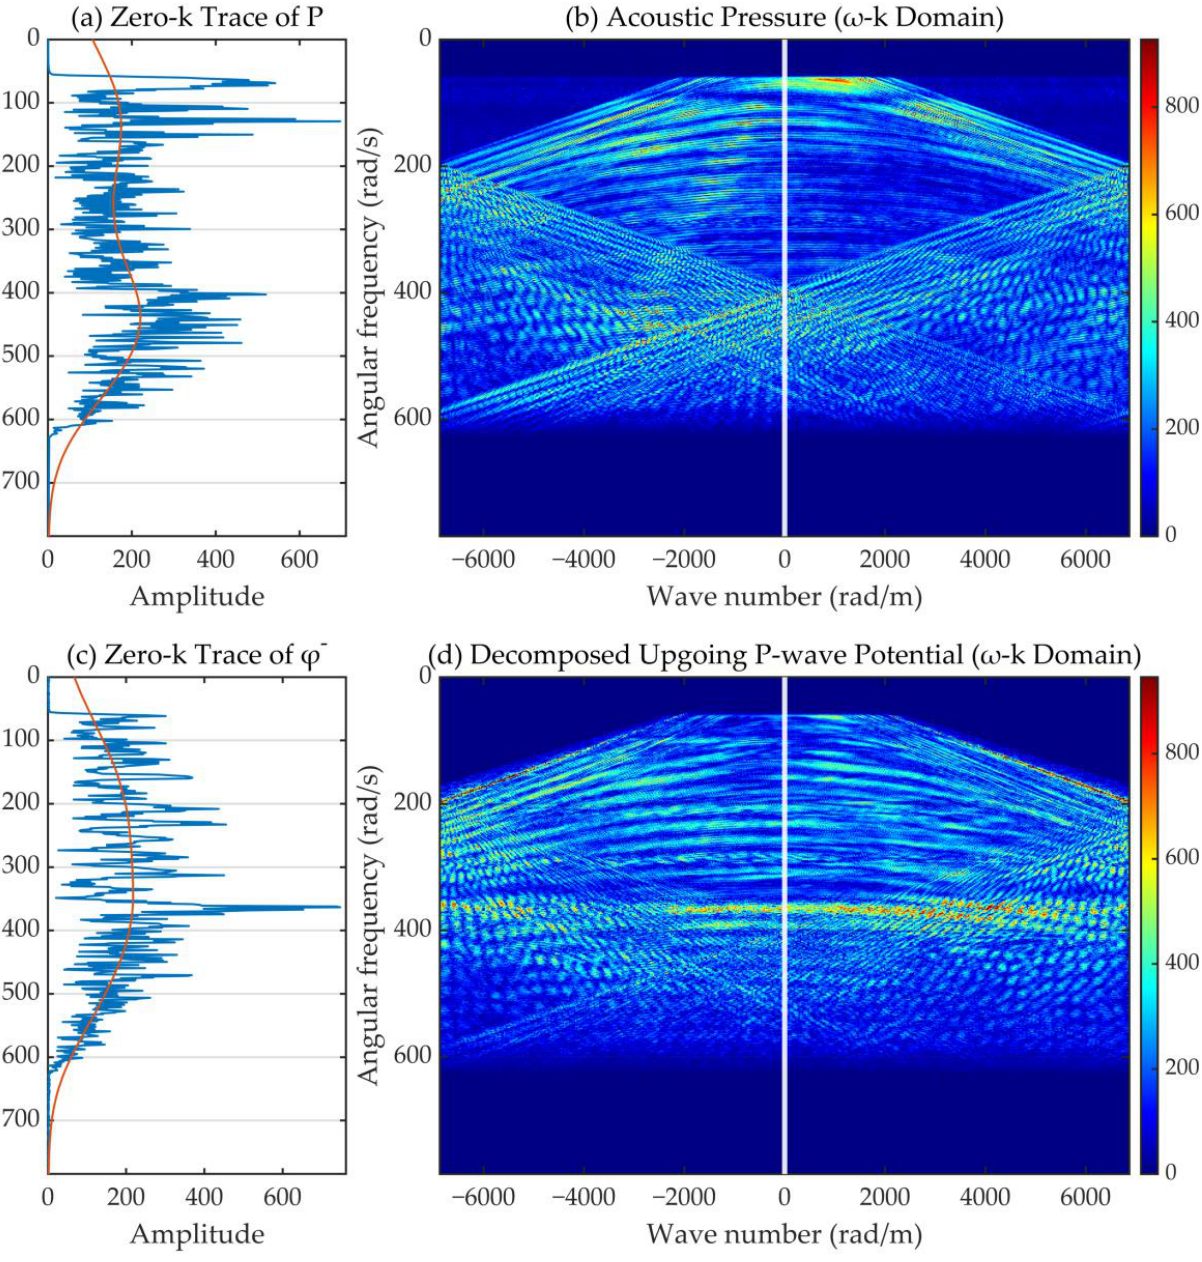
Figure 19. Demonstration of ( b ) the original acoustic pressure recording (the slashes from the boundary are caused by spatial aliasing) and ( d ) the upgoing P-potential decomposed just below the seafloor in the ω - k domain. The corresponding zero-k trace samples (denoted by the white vertical lines), ( a ) for pressure, and ( c ) for upgoing P-potential are displayed on the left side. The blue curves with burrs are the zero-k data obtained by obtaining geometric mean of the two traces with the minimum absolute value of wavenumber. The orange curves are the trend curves obtained by executing outlier removal and smoothing algorithms to the blue curve.